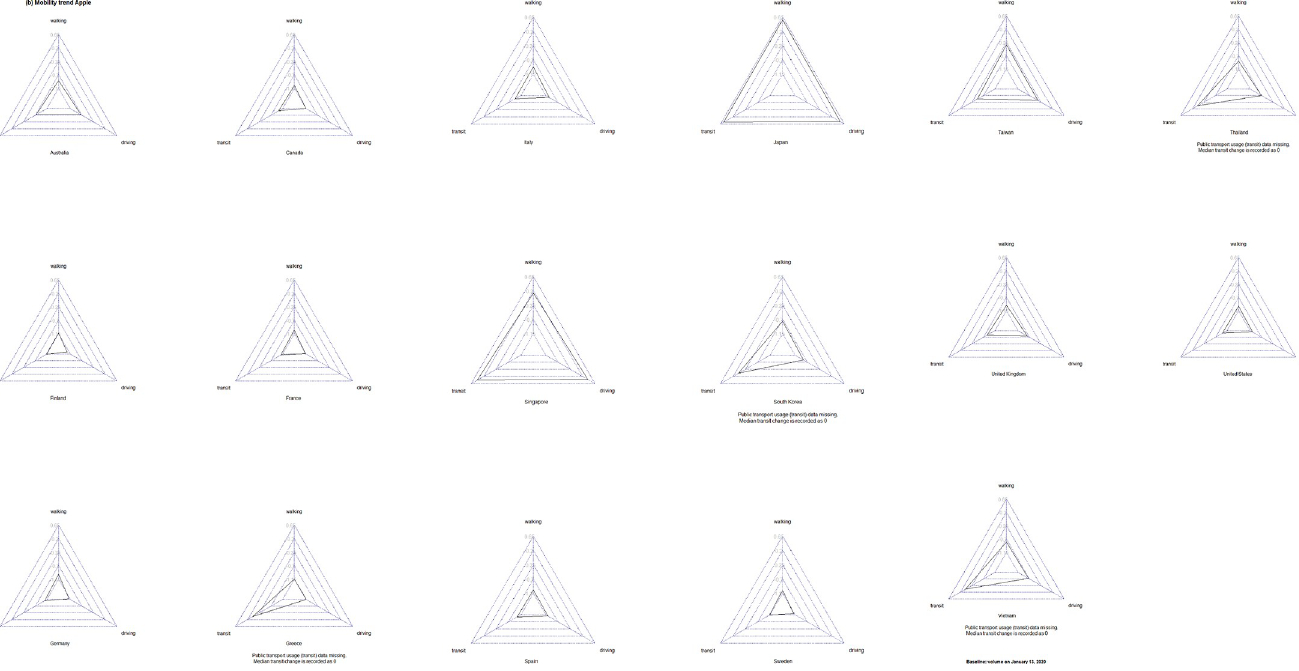
Fig 7. Radar charts of maximum mobility changes during studied period provided by